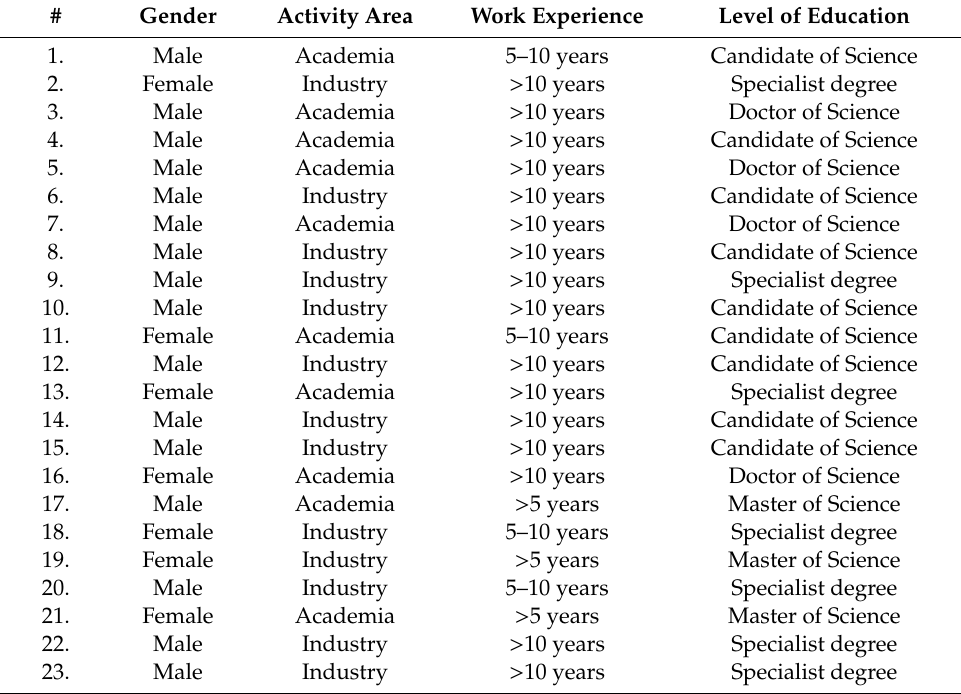
Table A2. Profiles of individuals who participated in the